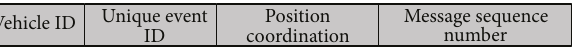
Figure 4: Incident warning message structure.